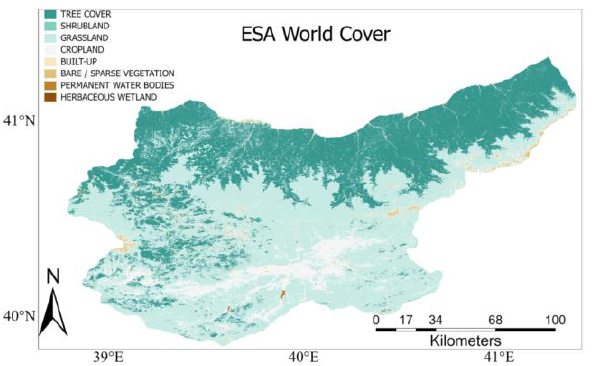
Figure 3 . LULC map of the study area, from ESA WorldCover data (ESA WorldCover, 2023).